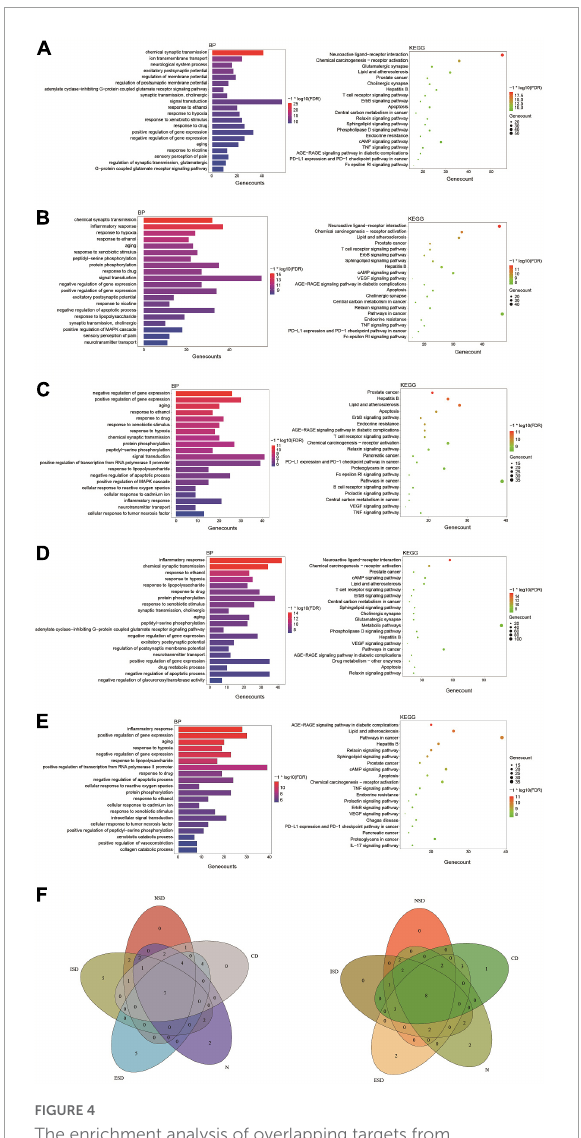
FIGURE4 The enrichment analysis of overlapping targets from component-related and disease-related targets. (A) Tremella aurantialba- nervous system diseases; (B) Tremella aurantialba- immune system diseases; (C) Tremella aurantialba- endocrine system diseases; (D) Tremella aurantialba- neoplasm system diseases; (E) Tremella aurantialba- cardiovascular system diseases; (F) Venn diagram of the results of enrichment analysis of the intersection of Tremella aurantialba -five diseases. The results of GO-BP enrichment analysis are on the left and KEGG enrichment analysis are on the